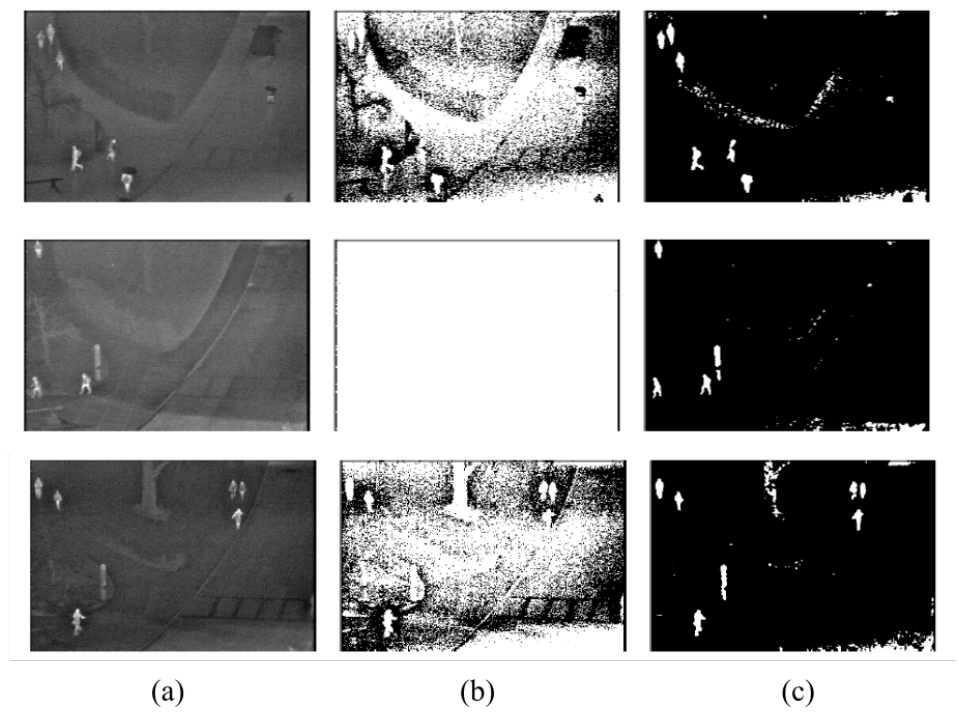
Figure 7. Comparison of outputs using MCET and the proposed method on images from the OSU Thermal database. ( a ) Original image; ( b ) minimum cross entropy; ( c ) proposed